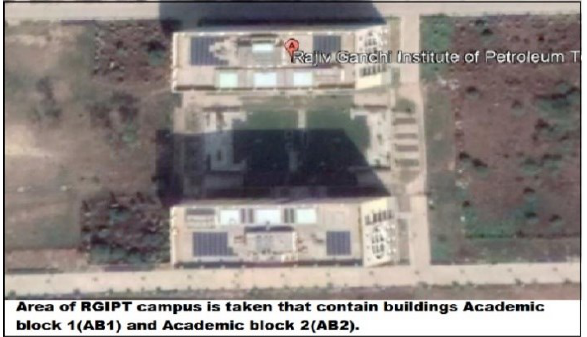
Figure 1. Project Area of RGIPT